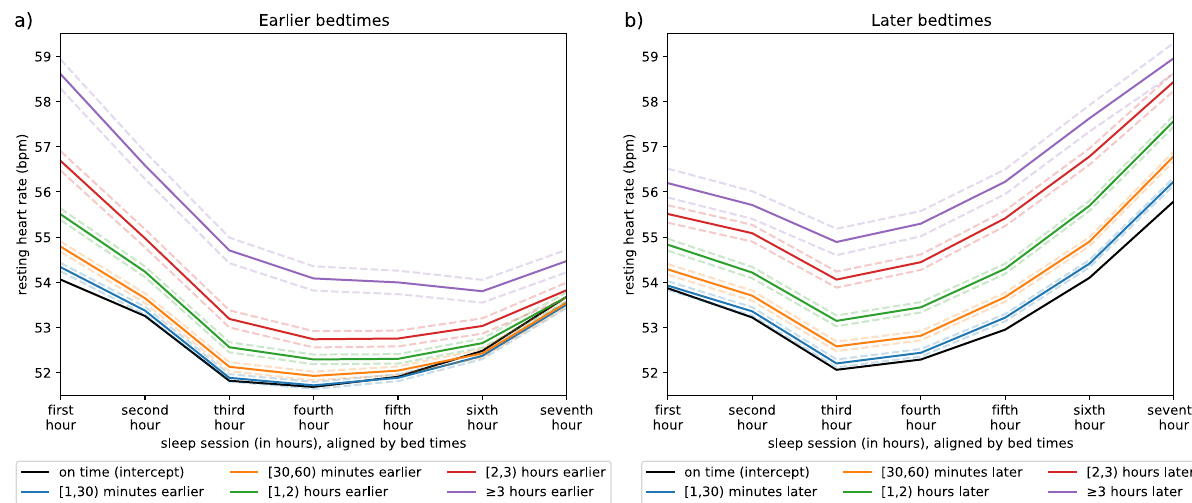
Fig. 1 Resting heart rate across bedtimes. The panels show the hourly differences in resting heart rate across an average sleep session strati fi ed by bedtime. a Resting heart rate curves as one goes to bed earlier than normal; b curves as one goes to bed later than